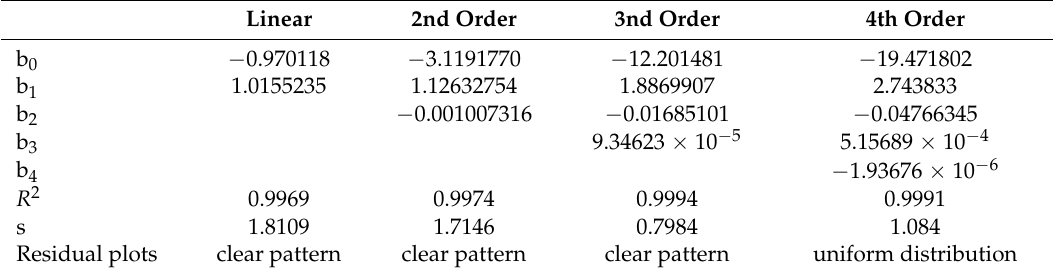
Table 5. Estimated parameters and evaluation criteria for the linear and several polynomial equations for THT-B121 resistive sensors using 5 salt solutions.